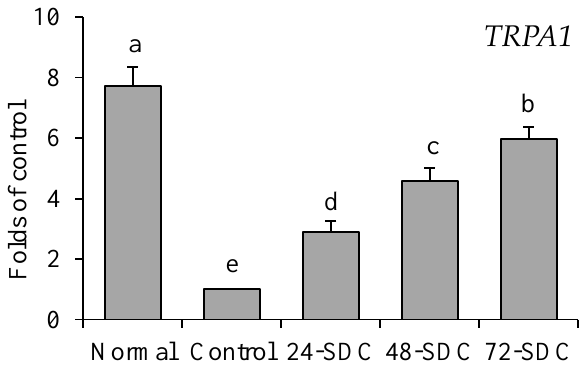
Figure 9. Messenger RNA level of transient receptor potential ankyrin 1 ( TRPA1 ) in gastric tissue of mice. Values presented are means ± standard deviation ( n = 3). Different letters indicate significant differences ( p < 0.05) between each group, and the same letters indicate that there is no significant difference ( p > 0.05) between each group according to Tukey’s test for multiple comparisons. 24-SDC: 24-h-fermented Shuidouchi; 48-SDC: 48-h-fermented Shuidouchi; 72-SDC: 72-h-fermented Shuidouchi.